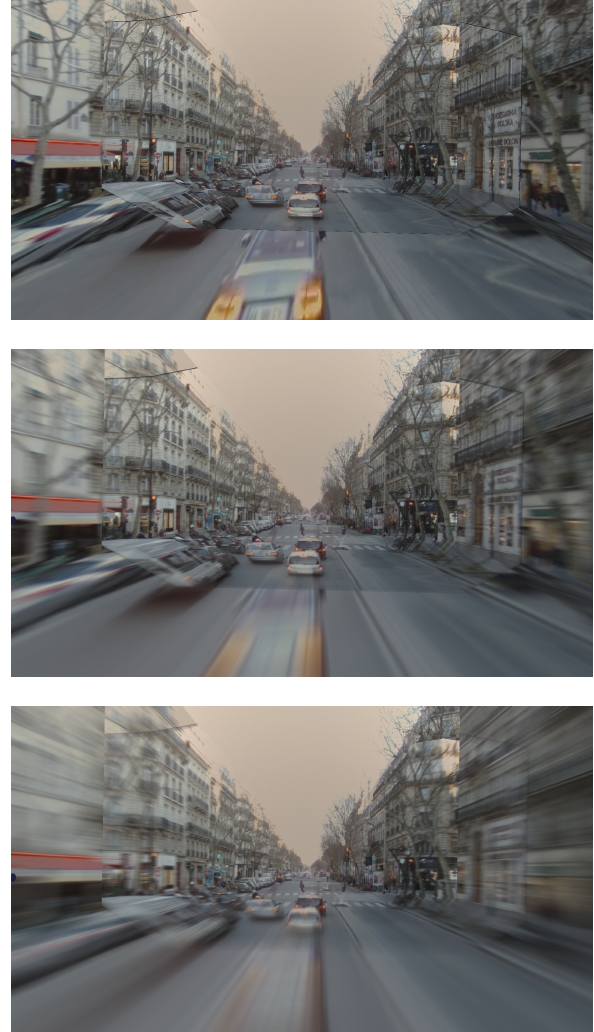
Figure 7: Regular filtered blending. (Top) No uncertainty has been introduced: this is only a linear blend of two 16-meter- separated textures projected on a LOD1 city model proxy. (Mid- dle) 1 meter depth uncertainty. (Bottom) 4 meters depth uncer-